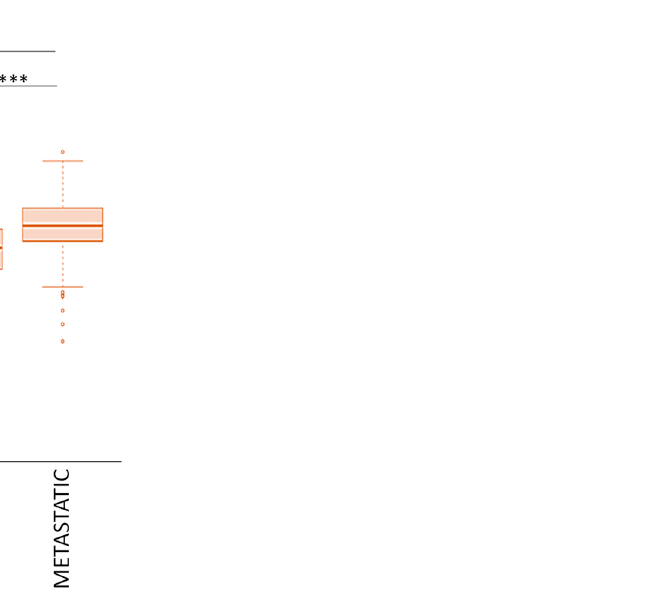
according to the TCGA Research Network (https://www.cancer.gov/tcga accessed on 18 June 2020).